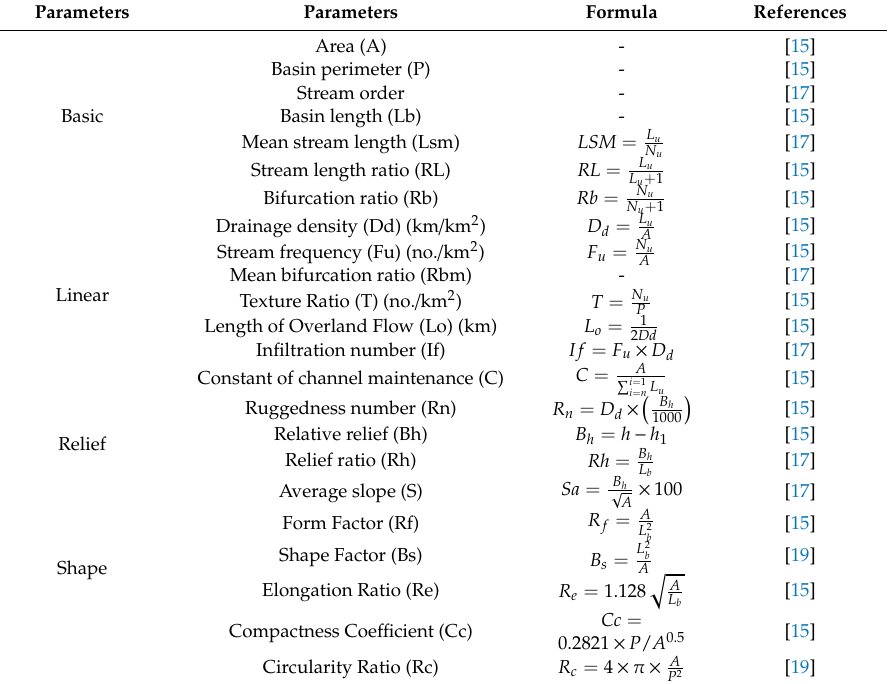
Figure 3. Interferometric synthetic aperture radar (InSAR) data ‐ processing procedure for digital elevation model (DEM) production.